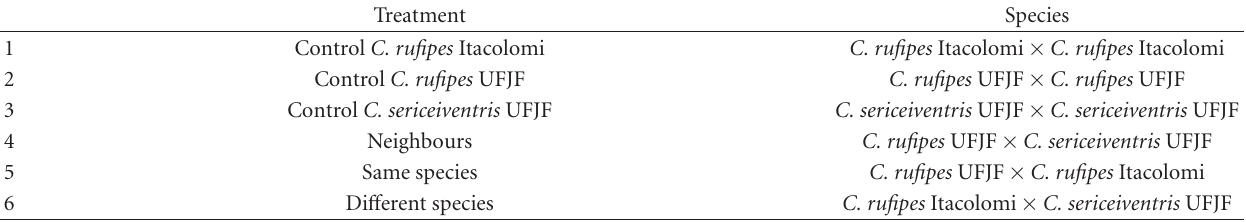
Table 1: Dyadic encounters occurring at the laboratory of the Federal University of Juiz de Fora (UFJF) for all treatments and species involved.